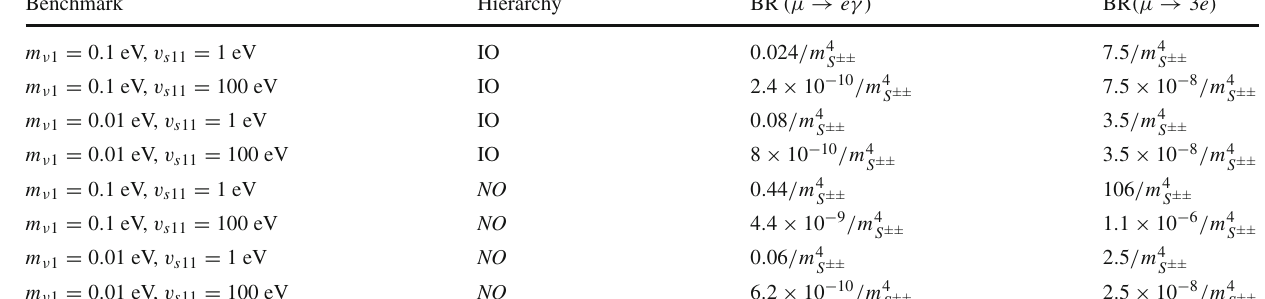
the doubly charged scalar is in GeV units. The neutrino masses in the IO scenario are given by m 2 ν